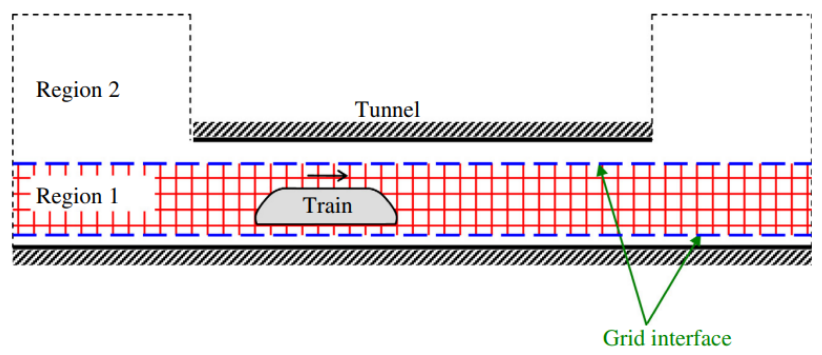
Figure 6. Schematic diagram of the sliding mesh method [43].